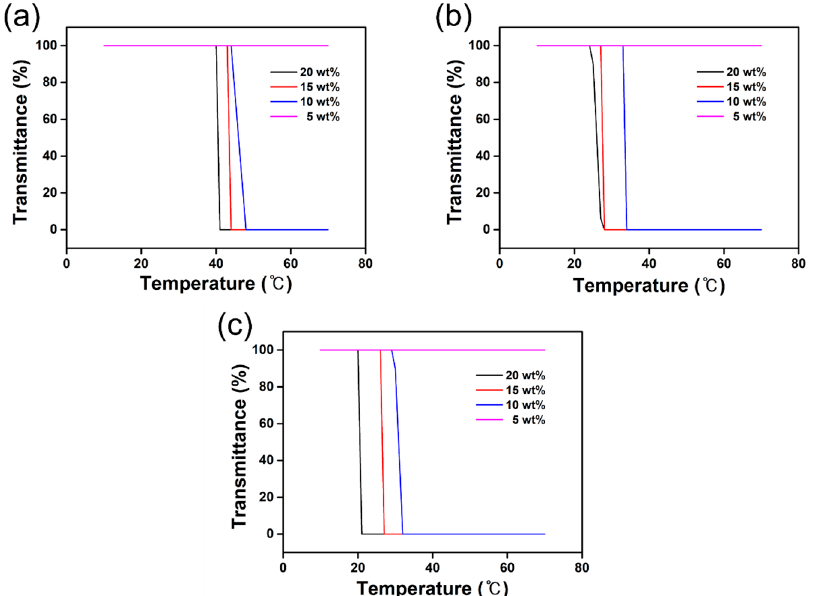
Figure 7. Transmittance curve of tetrabutylphosphonium ( a ) 4-methylbenzenesulfonate ([TBP][MBS]), ( b ) 2,4-dimethylbenzenesulfonate ([TBP][DMBS]), and ( c ) 2,4,6-trimethylbenzenesulfonate ([TBP][TMBS]) according to the temperature change.